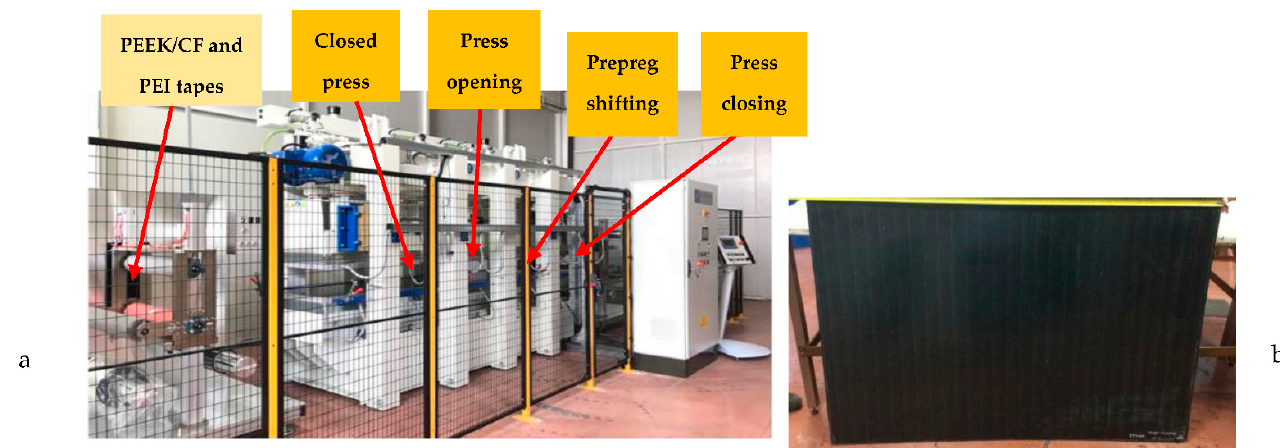
Figure 5. Hybrid material manufacturing equipment at NOVOTECH (Italy) ( a ) and a flat skin panel produced using the developed hybrid thermoplastic material ( b ).